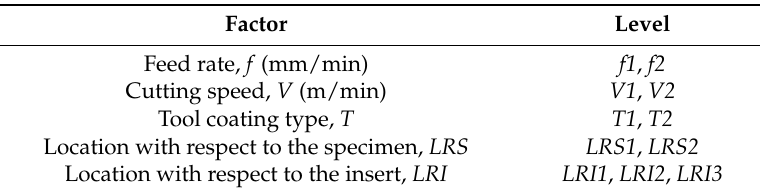
Table 1. Factors and